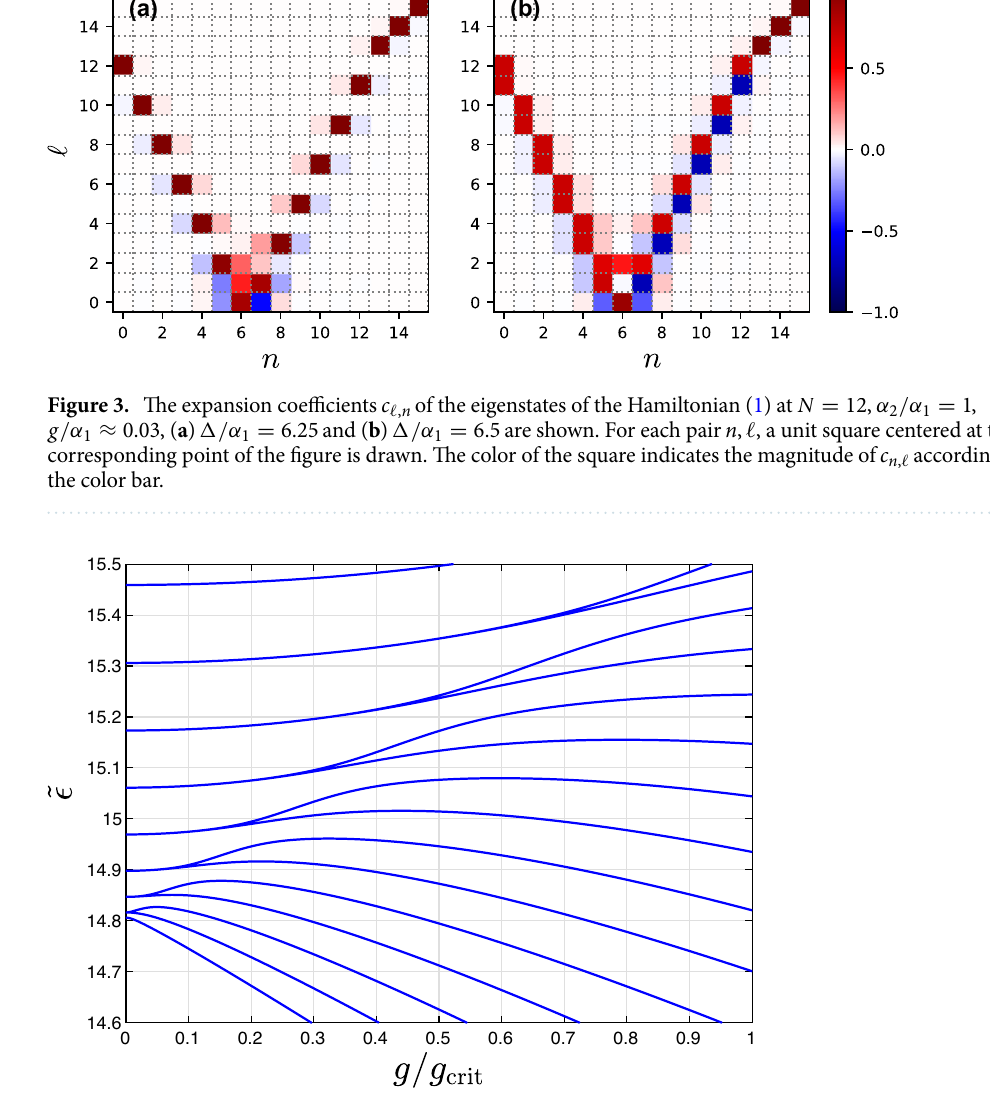
Figure 4. The dimensionless eigenenergies ε denoting the eigenenergies) as functions of the coupling g for µ N � µ N (α 1 α 2 )/ 2 α 2 N . For the definition of g crit , see “Classical = + −